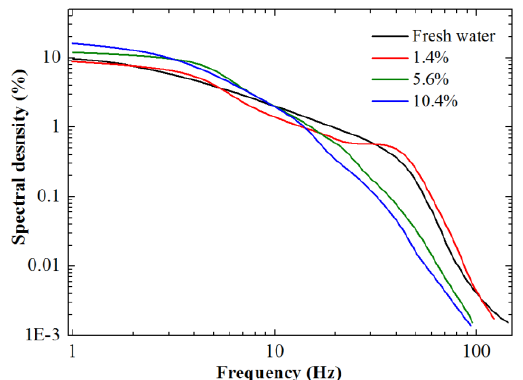
Figure 12. Relationships of spectral density distribution with concentrations taken by Wang and Qian [37].